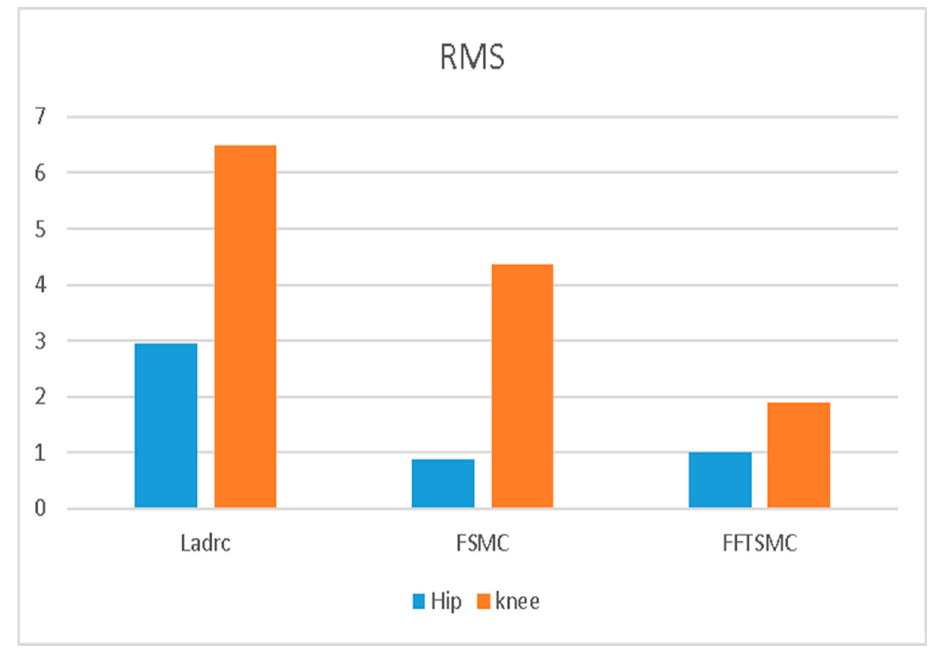
Figure 10. RMSE comparison of LADRC, LESO-based FSMC and LESO-based FFTSMC.